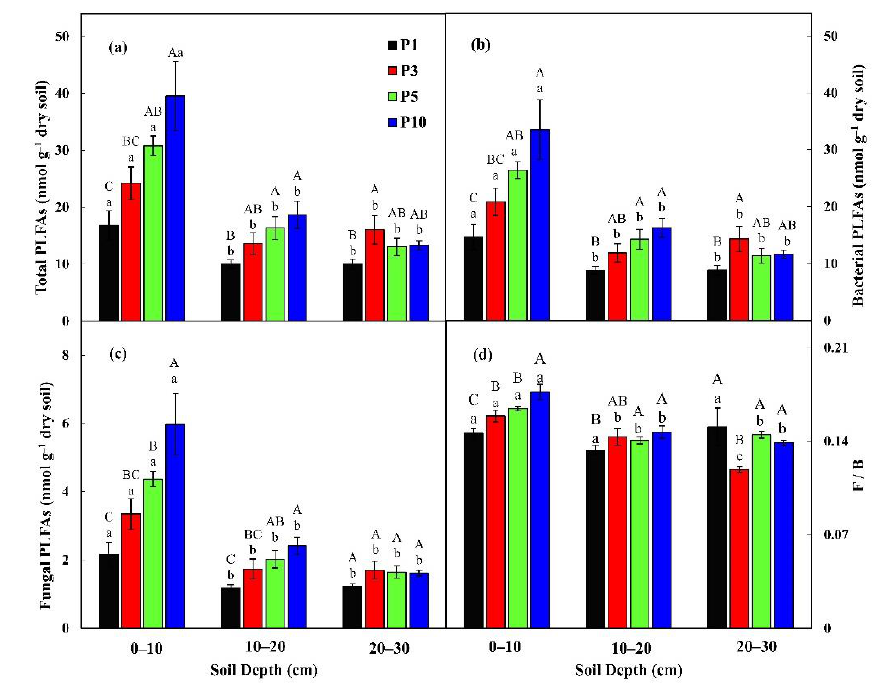
Figure 2. Soil total PLFAs ( a ), bacterial PLFAs ( b ), fungal PLFAs ( c ), and F/B ratios ( d ) in different soil depths (0–10, 10–20, and 20–30 cm) under pomegranate plantation of different years. Values followed by a different uppercase letter are significant difference ( p < 0.05) between different years in the same soil depth; values followed by a different lowercase letter are significant difference between three soil depths in the same year. (P1, pomegranate plantation for 1 year; other names (P3; P5; P10) are in the same manner; error values are mean ± standard error; n = 5).